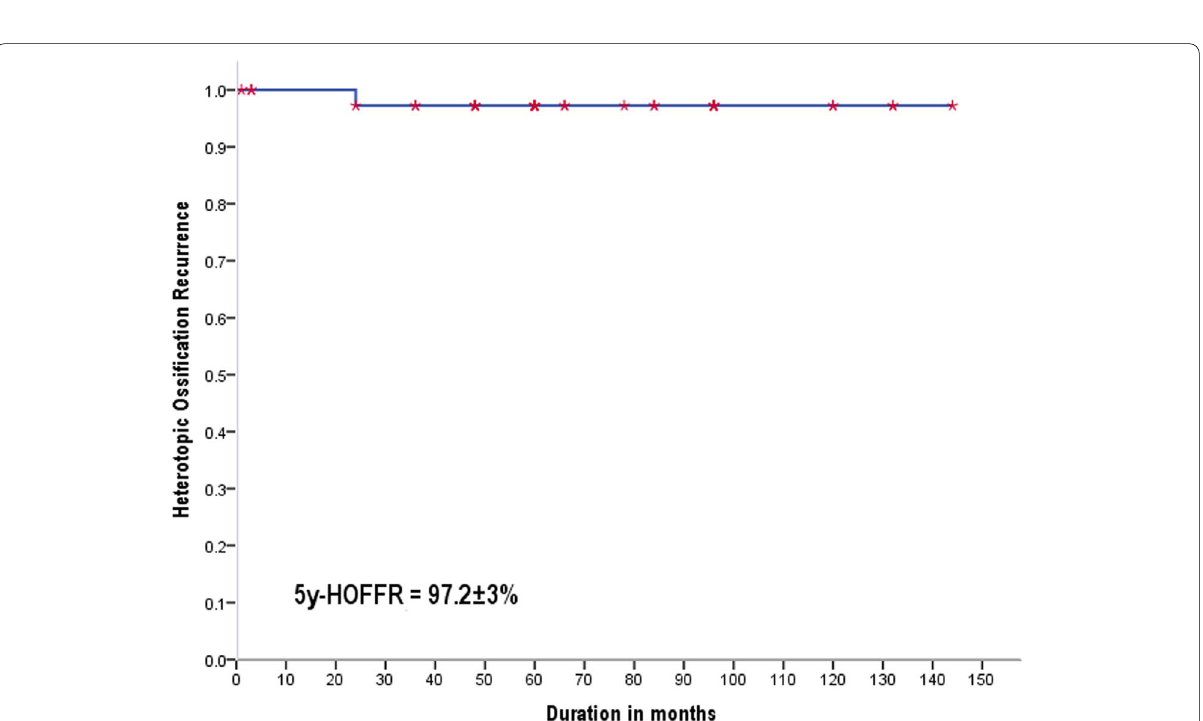
Fig. 5 Heterotopic ossification recurrence. (The curve shows the heterotopic ossification failure-free rate